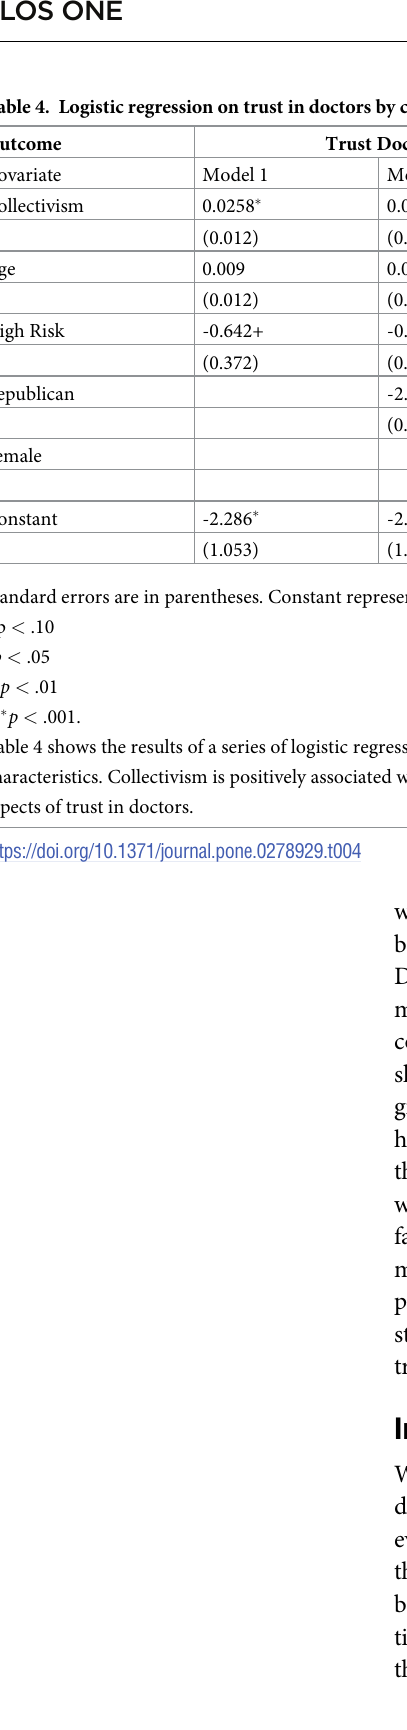
Table 4. Logistic regression on trust in doctors by collectivism (N = 251).